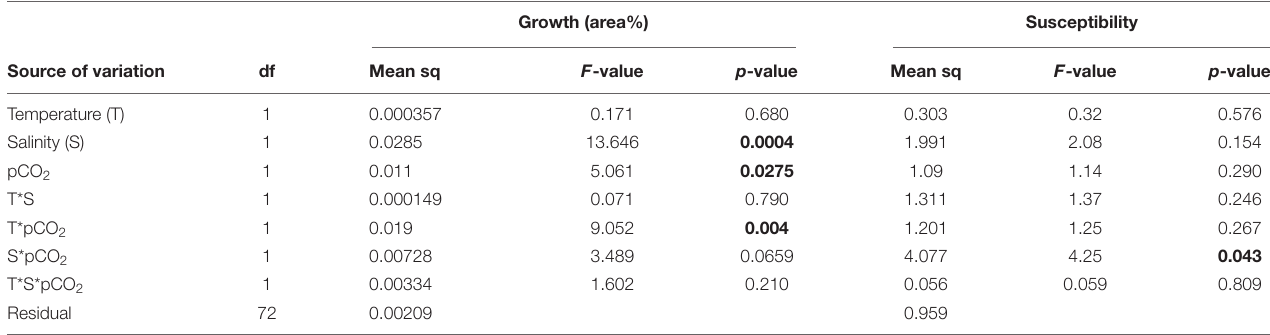
TABLE 2 | Summary of effects of temperature (ambient and high), salinity (ambient and low), and pCO 2 (ambient and elevated) for growth on Fucus vesiculosus and susceptibility to Littorina obtusata . Growth